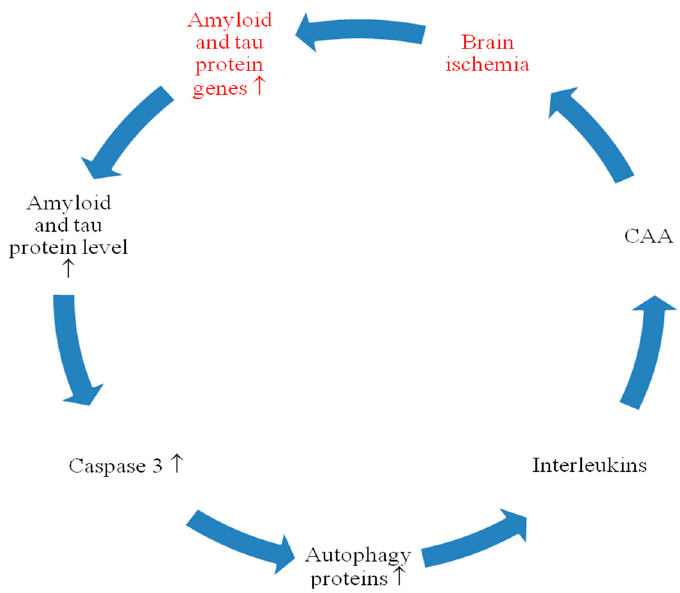
Figure 3. Cross talk between Alzheimer’s disease-associated proteins and their genes after brain ischemia. CAA: cerebral amyloid angiopathy. ↑ : increase.